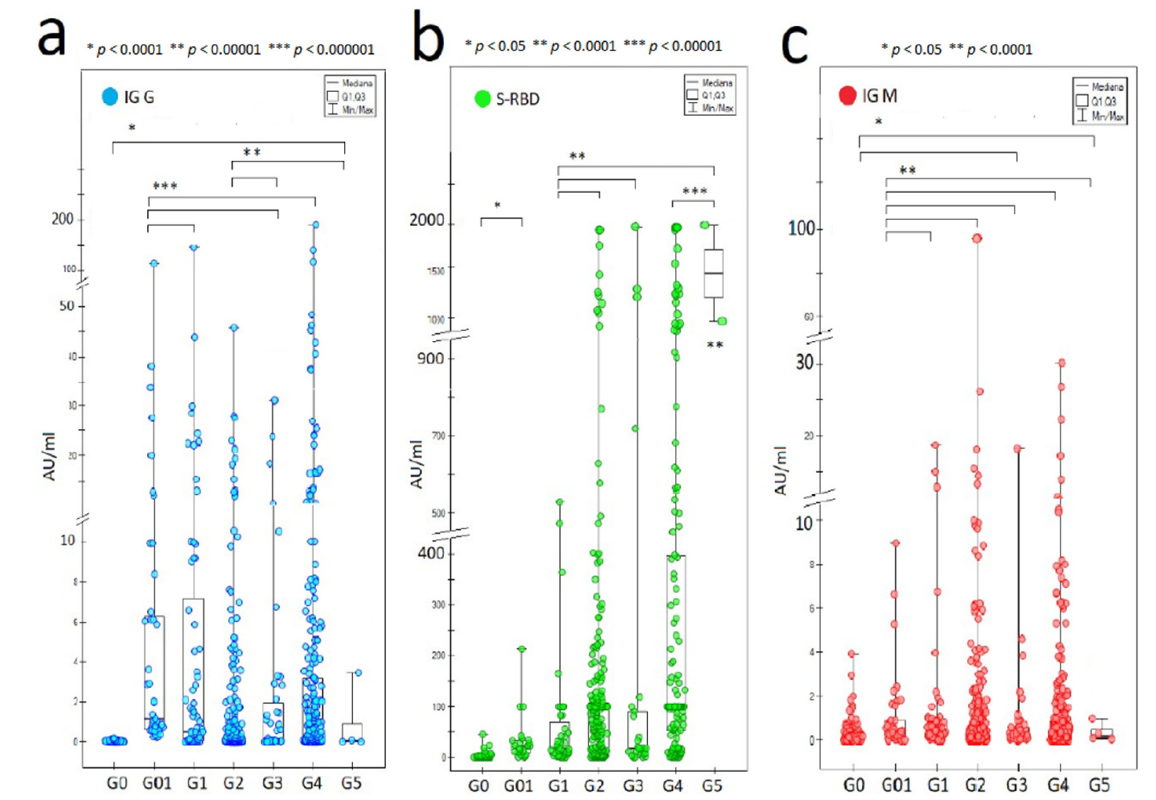
Figure 2. The absolute concentrations of SARS-CoV-2 IgG ( a ), IgM ( c ), and S-RBD IgG ( b ) antibodies in each study group, G0-G5 ( p < 0.05 appropriately; Kruskal–Wallis ANOVA).